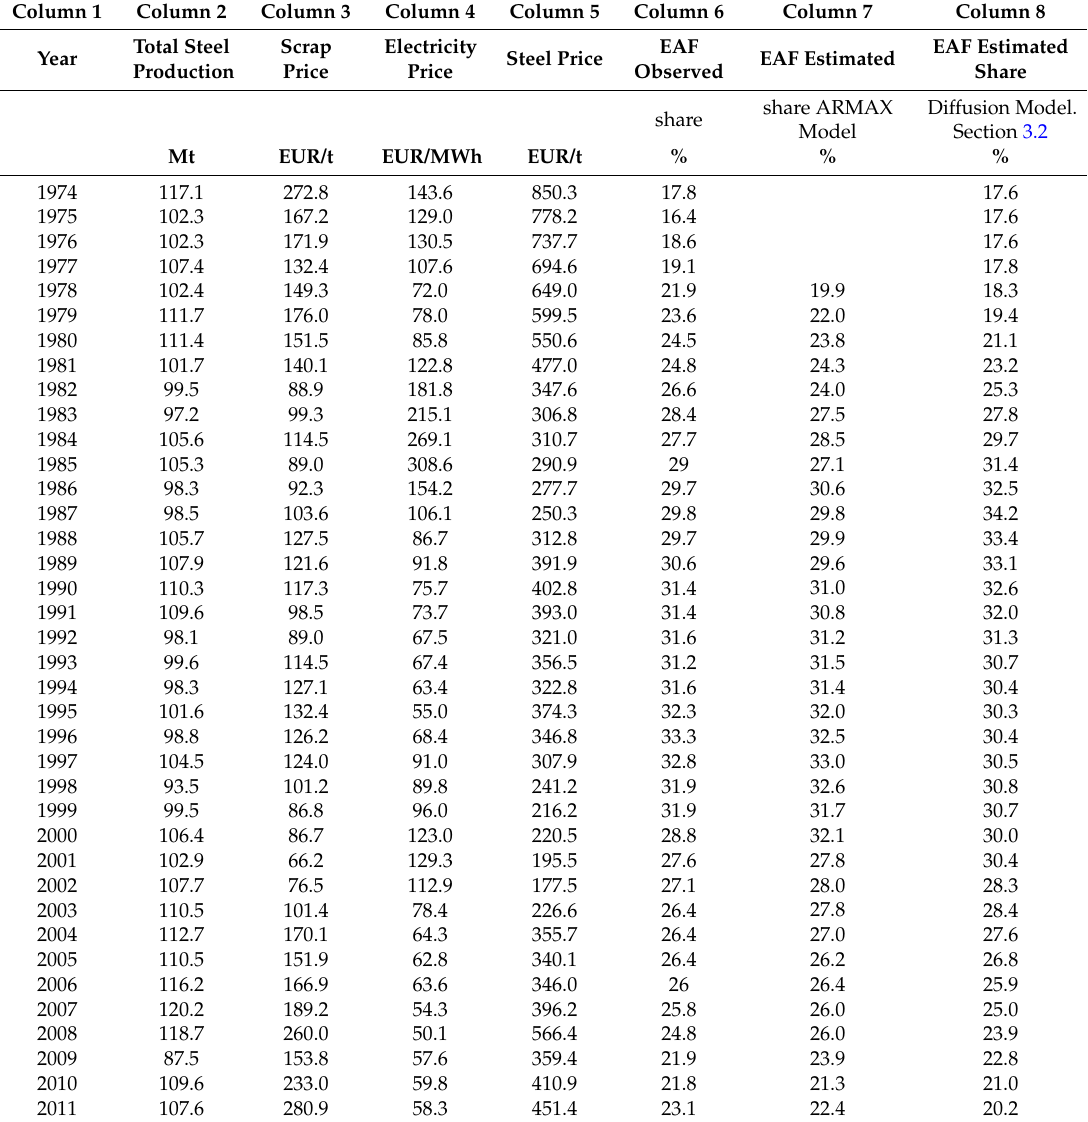
Table 1. Parameters explaining the share of steel production using EAF in Japan, observed share (column 6) and its estimations (columns 7 and